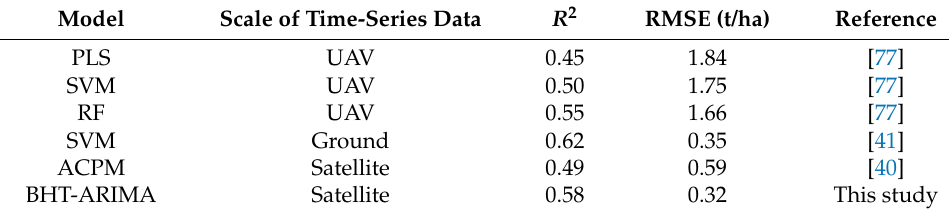
Table 7. Comparisons of different RS methods for winter wheat yield estimation.